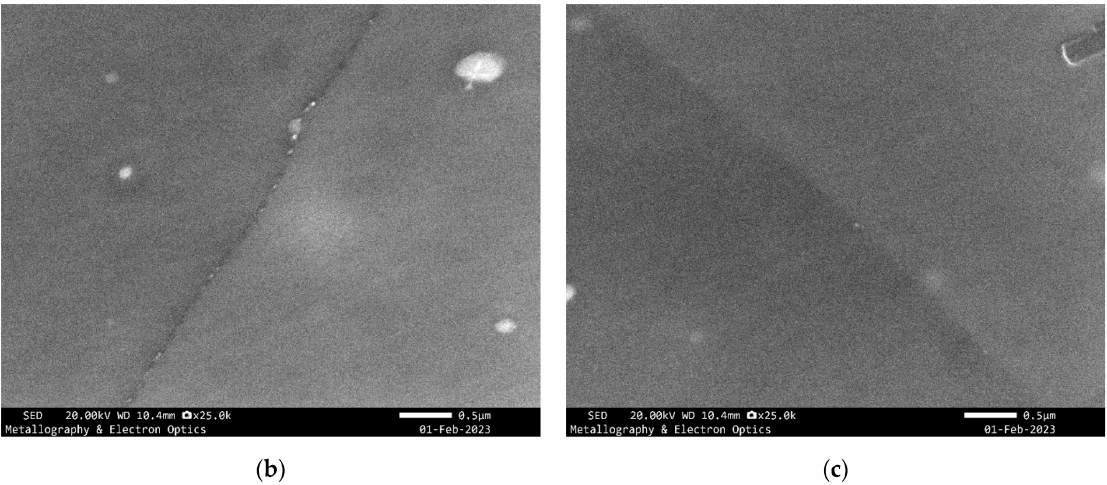
Figure 9. Precipitation behaviors on HAGBs ( a ), LAGBs ( b ), and SGB ( c ) of the SC sample in AOI 5 in the mid-thickness region of the profile.